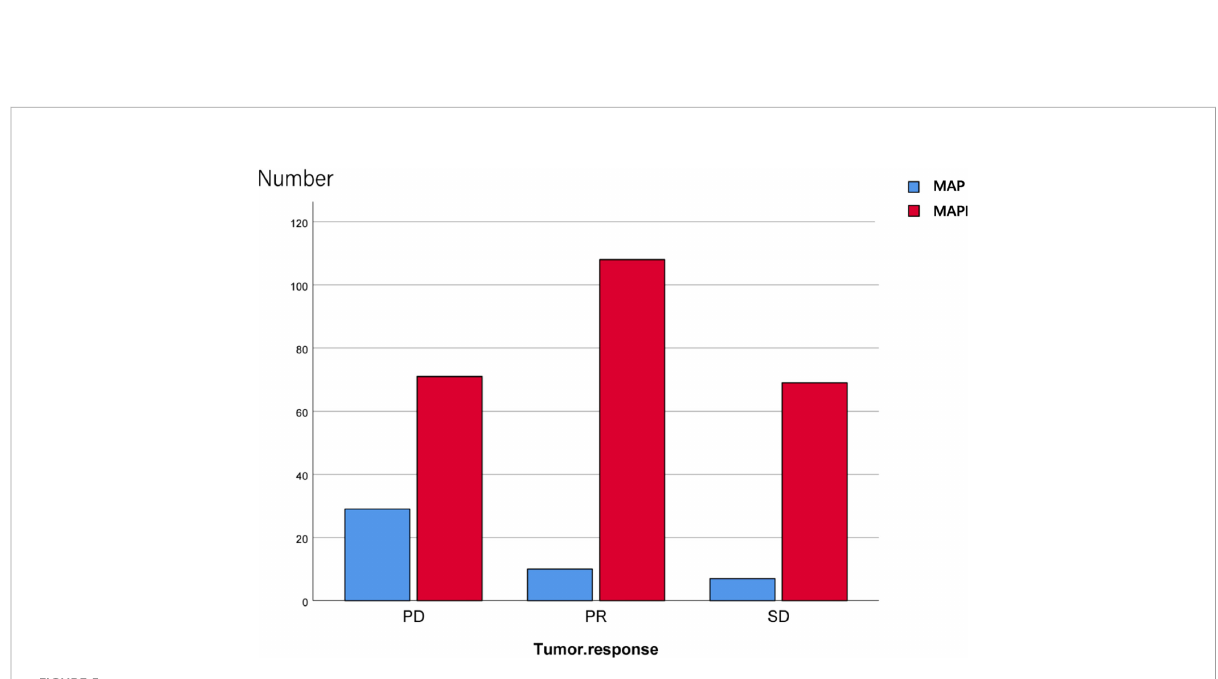
FIGURE 5 Effects of IFO on the tumor response after neoadjuvant chemotherapy.